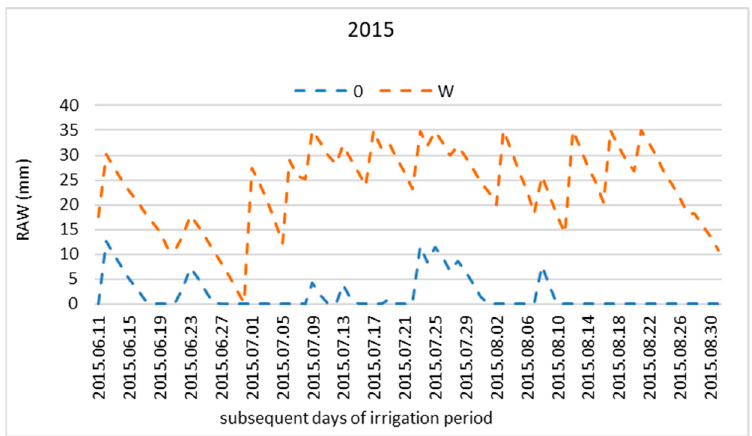
Figure 2. The balance of water readily available to plants in the soil layer with controlled moisture in the period from 11 June to 31 August 2015 (dry season) (0–rainfed, W–irrigation).